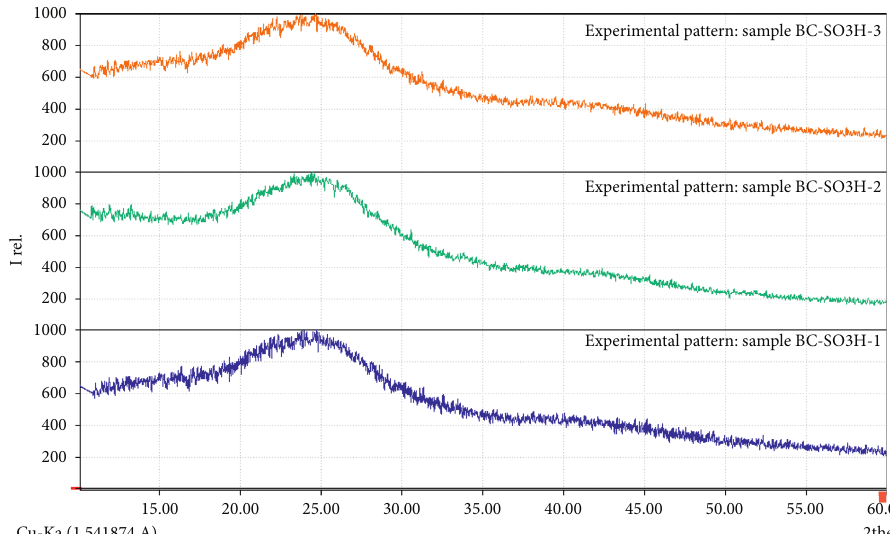
Figure 2: XRD pattern of catalyst prepared by (a) 98%, (b) 96%, and (c) 94% H